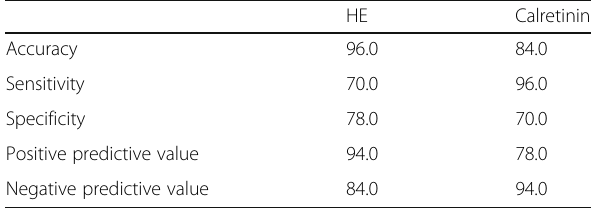
Table 3 Validation values of HE staining and